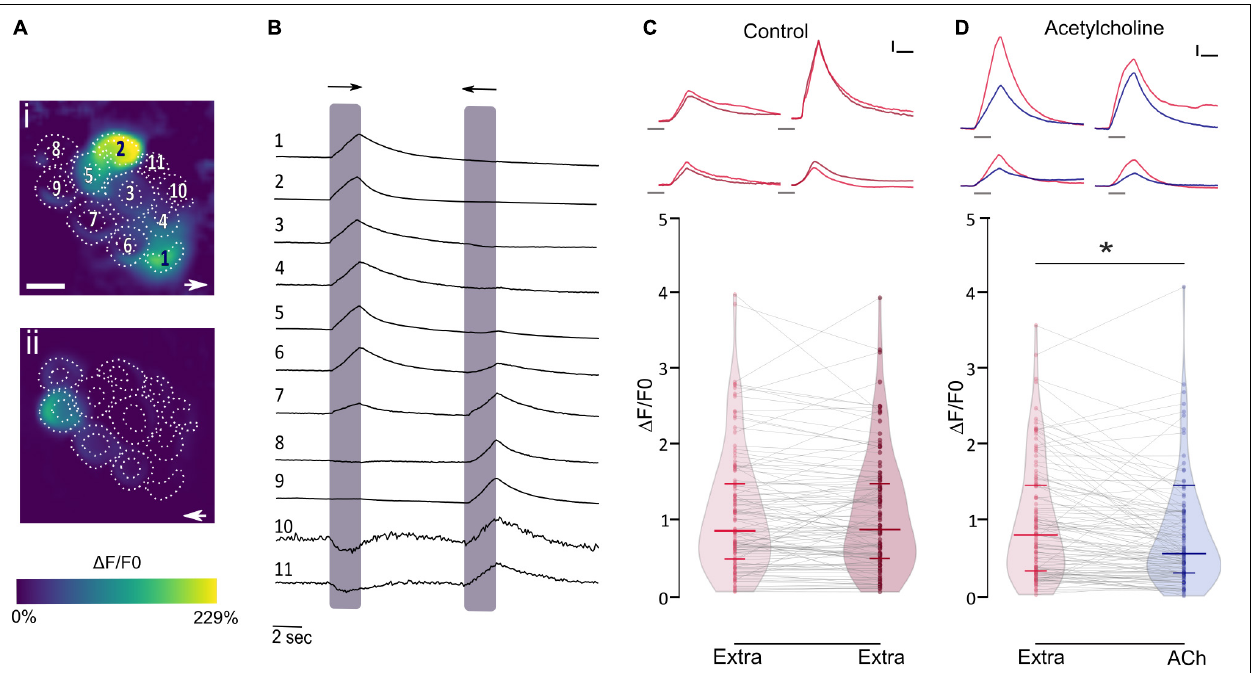
FIGURE 3 | ACh inhibits mechanically evoked Ca 2 + signals. (A) Representative functional Ca 2 + images of a double-transgenic neuromast expressing GcAMP7a in HCs during a 2 s mechanical stimulus in either the anterior–posterior (i) or in the posterior–anterior direction (ii). ROIs are drawn around each HC. (B) Representative temporal curves of mechanosensitive Ca 2 + responses ( (cid:49) F/F0) of HCs numbered in A. Shaded areas indicate the time when the neuromast was mechanically stimulated. (C) Top, Representative temporal (cid:49) F/F0 curves of four HCs over two trials with the same stimulation 1 min apart (1 ◦ stimulus, light red; 2 ◦ stimulus,